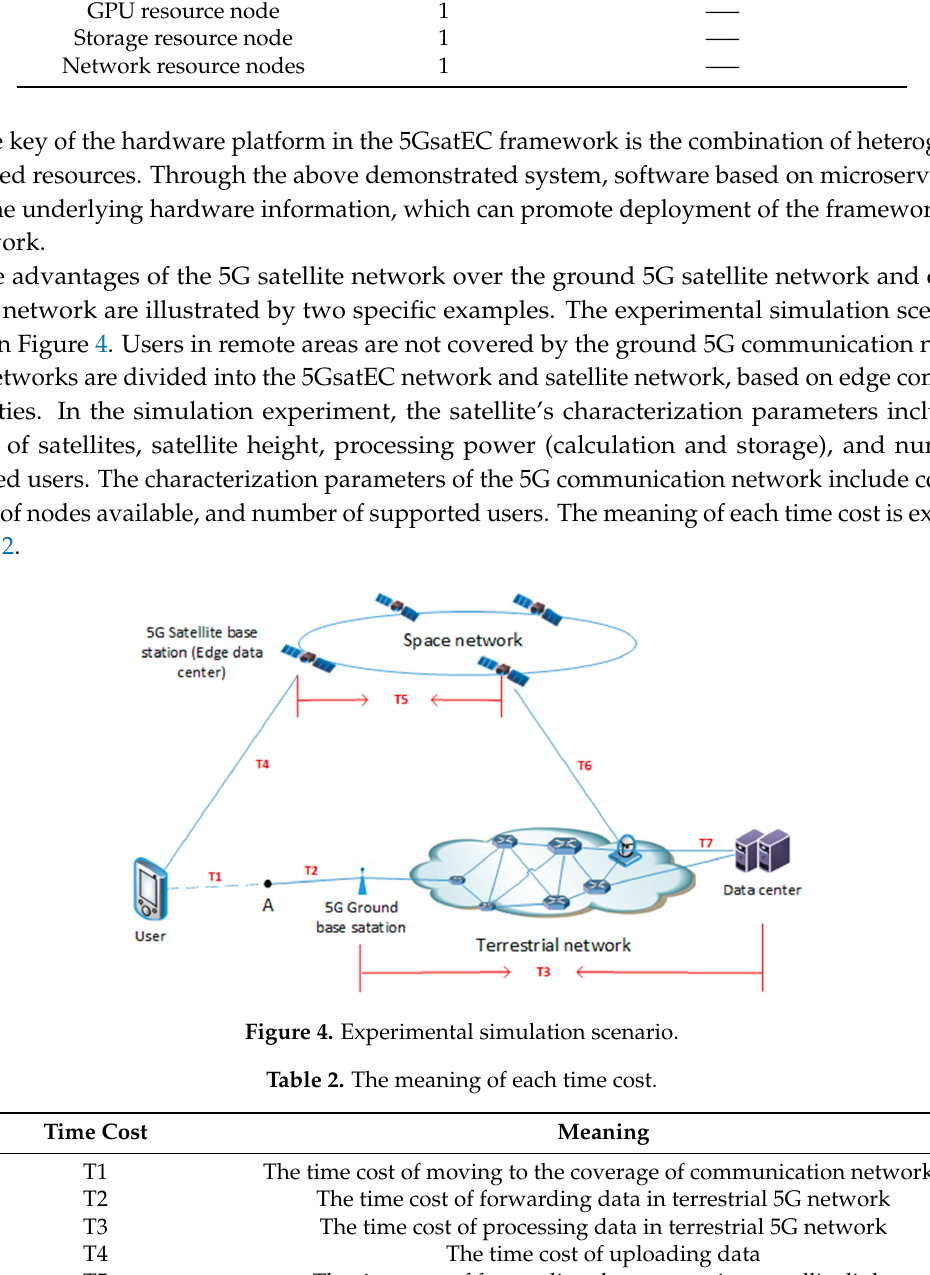
Table 1. Resources in the test platform.